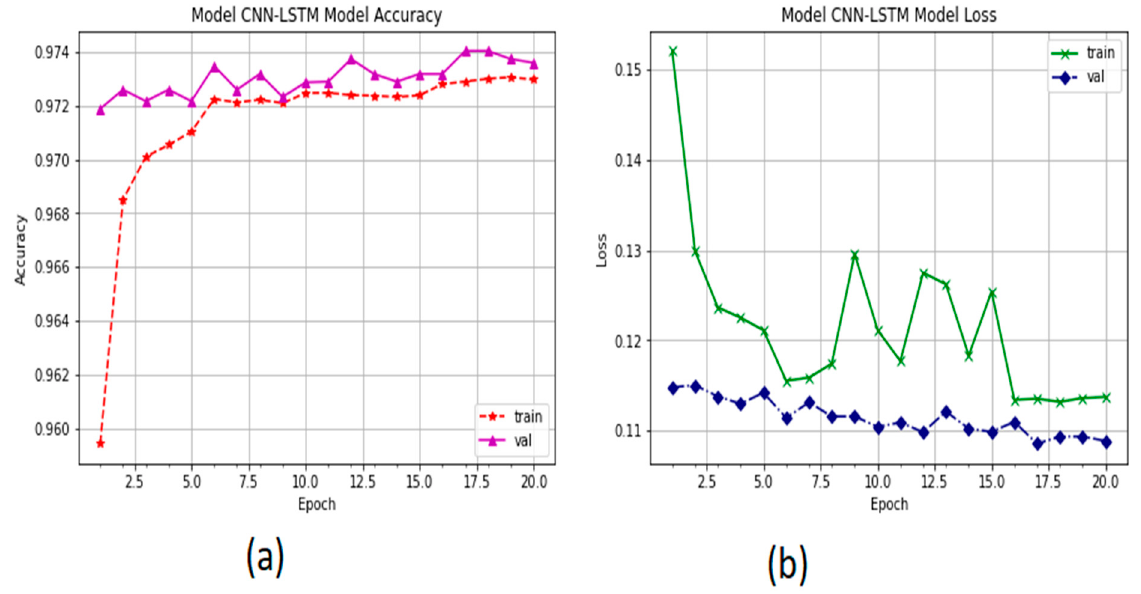
Figure 13. The performance of CNN–LSTM: ( a ) accuracy performance and ( b ) training and validation loss of the CNN–LSTM model in detecting flood, fuzzing, and normal packets in a CAN bus.